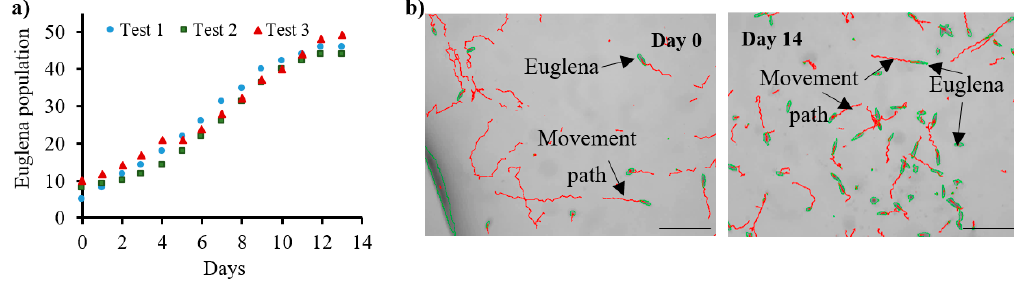
Figure 5. Culturing of E. gracilis on the LOC platform: ( a ) graph indicating exponential growth of these creatures, ( b ) microscope images of euglena colonies with software-enhanced detection of single cells and their movement paths. Micro-organisms were acquired from the macroscale culture and introduced into the LOC utilizing laboratory pipette (volume—1 µL) and covered by parafilm. The culturing process was performed in the middle microchamber under the daylight. Software processing was applied daily – fresh paths were generated each time. Scale bar—100 µm.